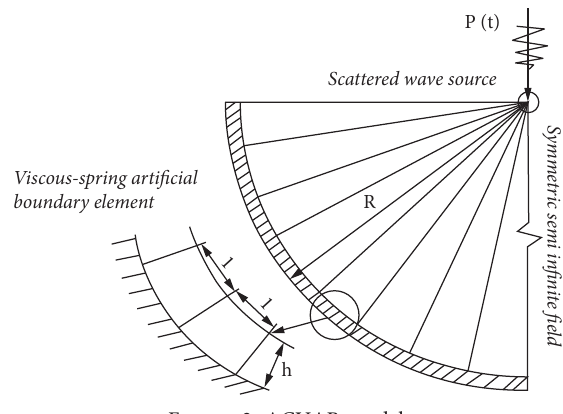
Figure 2: ACVAB model.